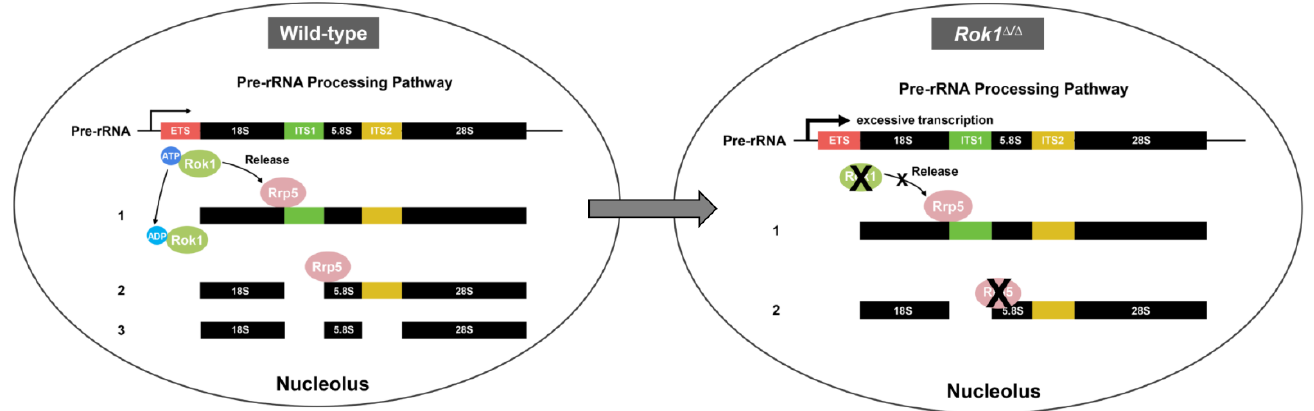
Figure 7. Model of Rok1 functions on ribosomal rRNA processing in Drosophila .